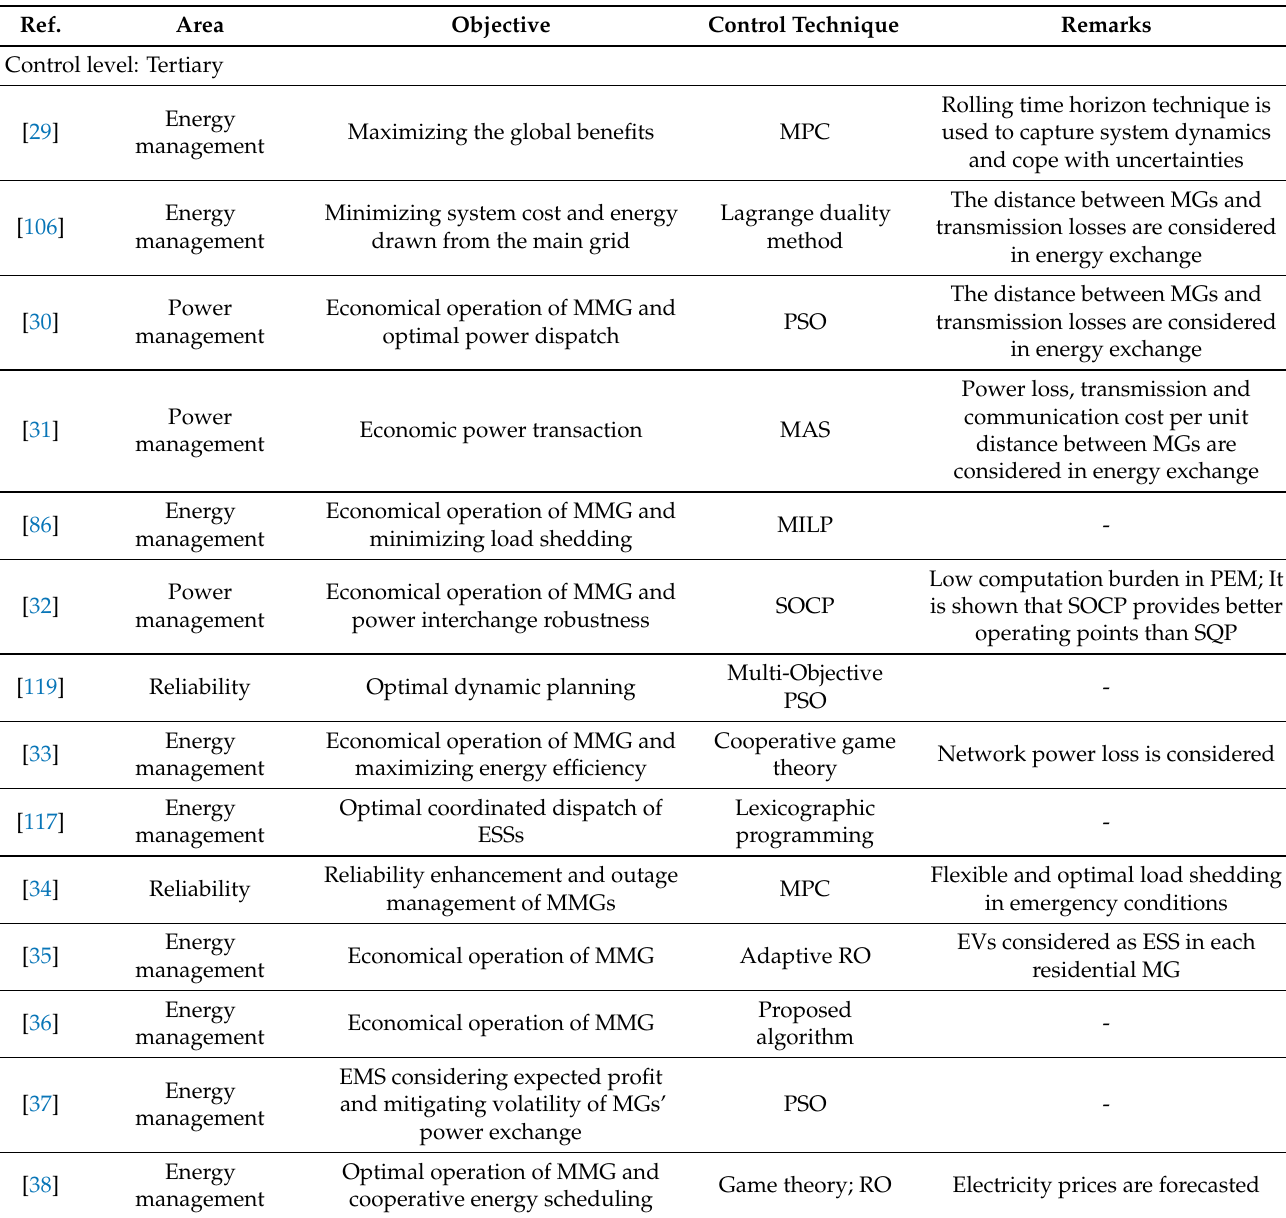
Table A2. Summary of the recently published articles on the centralized control of MMGs.